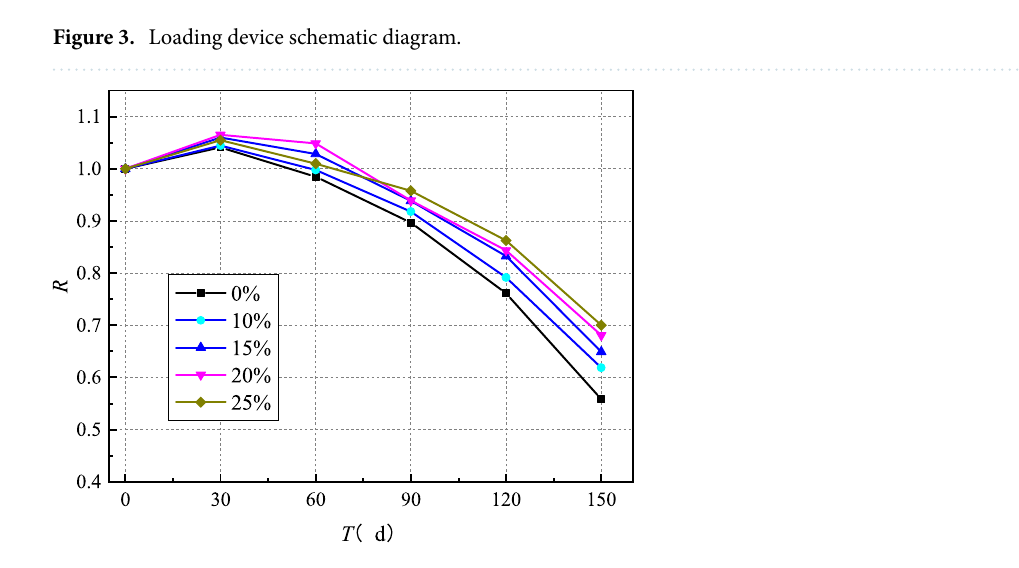
Figure 4. Time-varying curve of concrete compressive